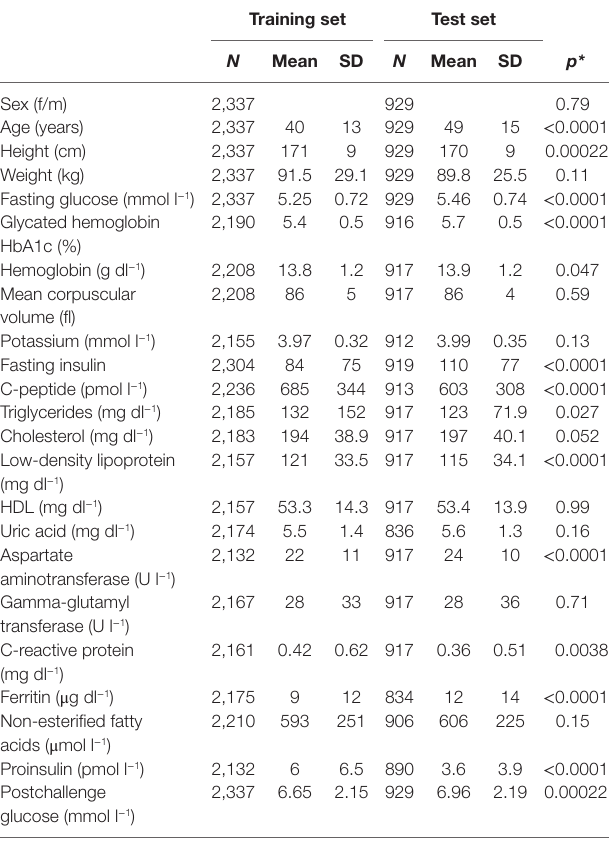
Table 2 | Characteristics of the training and test set for the feature variables and the target variable defining the classification. Training set Test